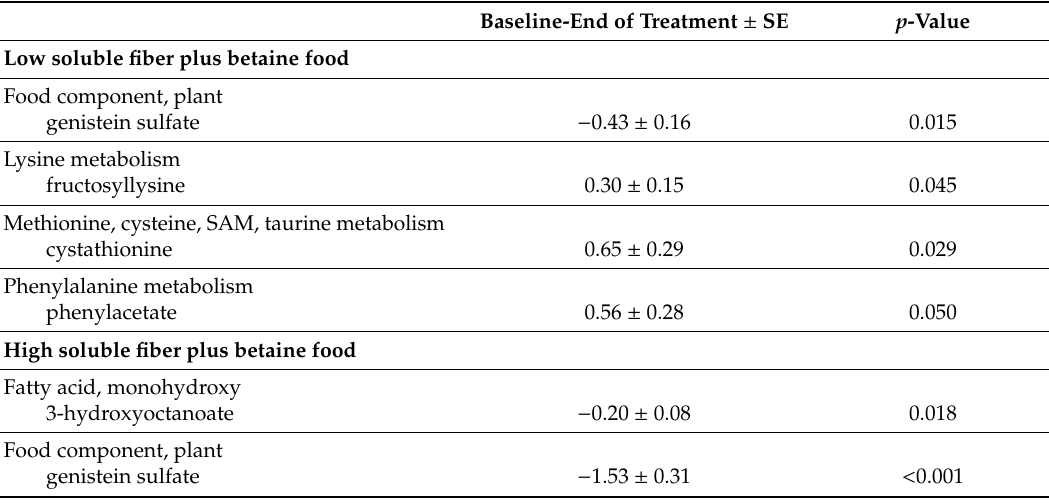
Table 7. Di ff erences from baseline in log-transformed data of fecal metabolites in dogs with early renal disease who consumed the low soluble fiber plus betaine and high soluble fiber plus betaine